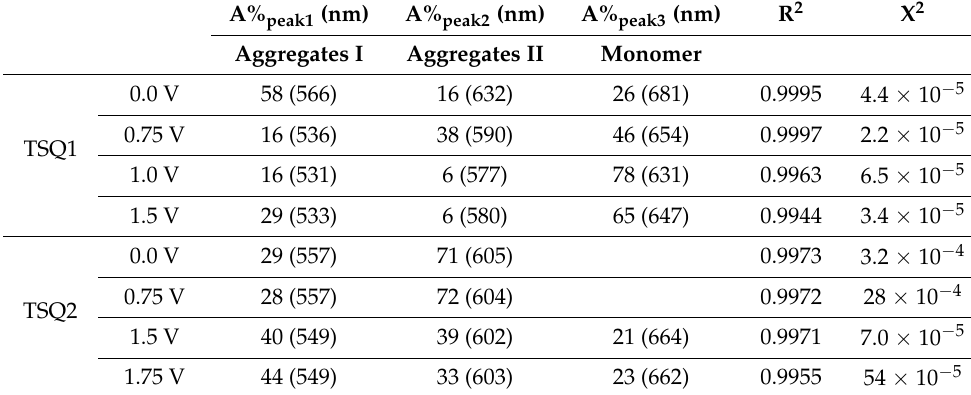
Table 2. Contribution of each fluorescence band to the overall emission of TSQs in the gel phase, calculated by the spectral deconvolution at different voltages.